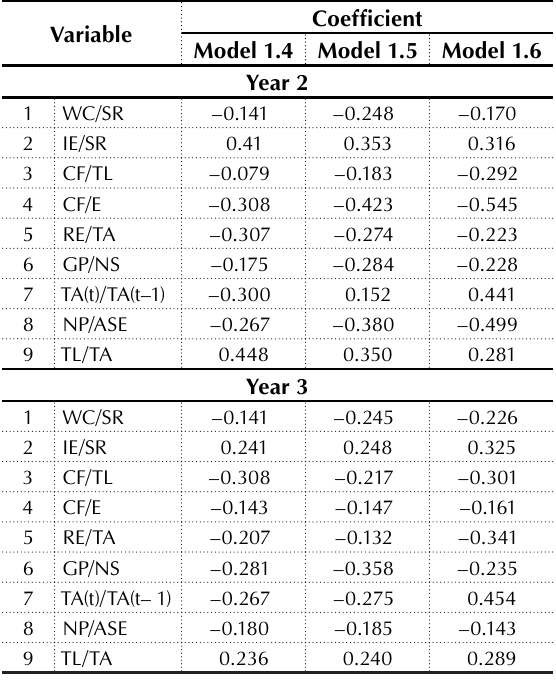
Table 3 (cont.). Stepwise selection results